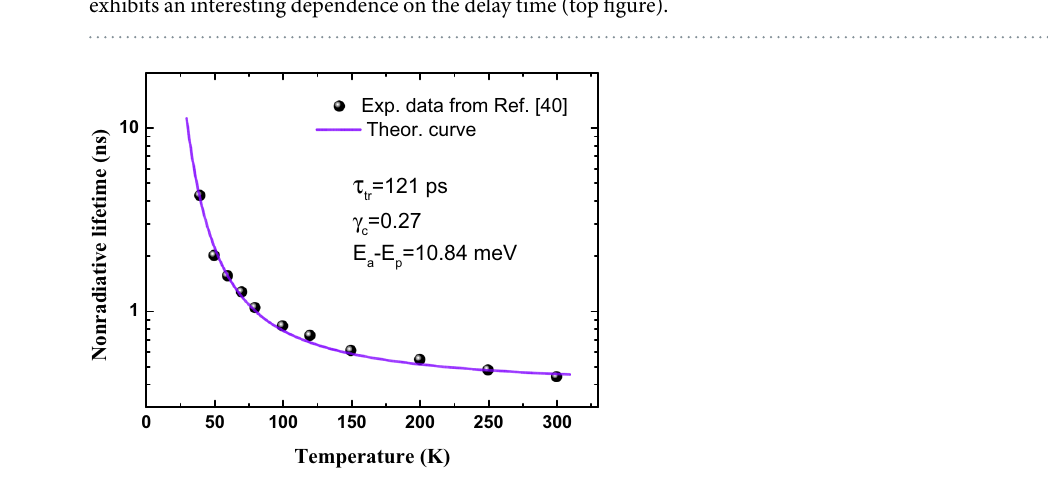
Figure 3. Temperature dependence (solid circles) of the nonradiative lifetime for localized excitons of InGaN MQWs, adopted from ref. 40. The solid line represents a best fitting with Eq.